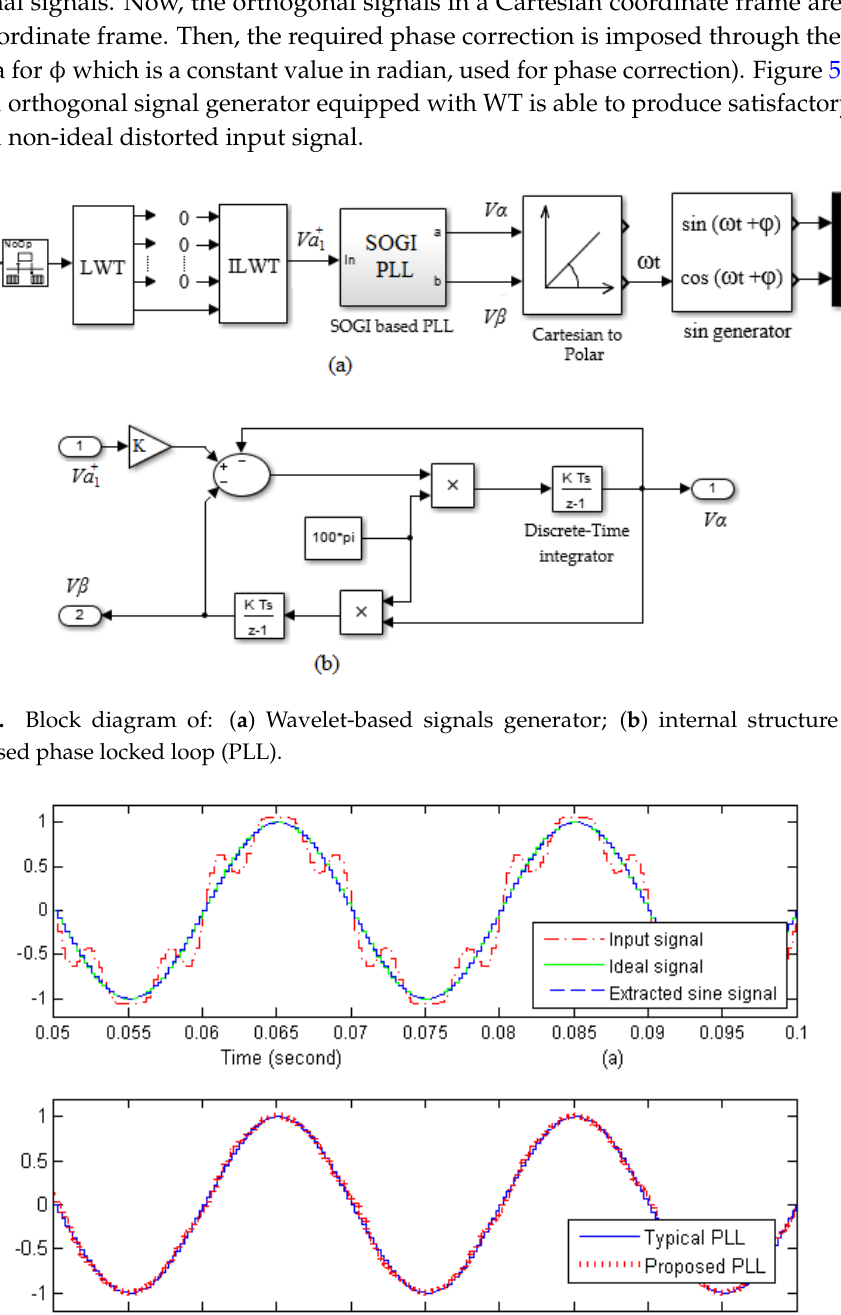
Figure 6. Voltage source inverter ( V SI ) forth leg controller to suppress the source-end zero current.